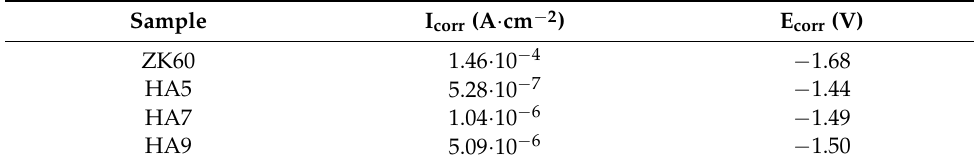
Figure 5. ( a ) Polarization curves of the ZK60 substrate and the HA-coated samples. ( b ) Equivalent circuits used to fit the impedance data for uncoated and coated ZK60 magnesium alloy samples. Bode ( c ) and Nyquist ( d ) plots of the HA-coated samples. Table 1. Corrosion potential and current density of the ZK60 and HA-coated samples in Hank’s so-